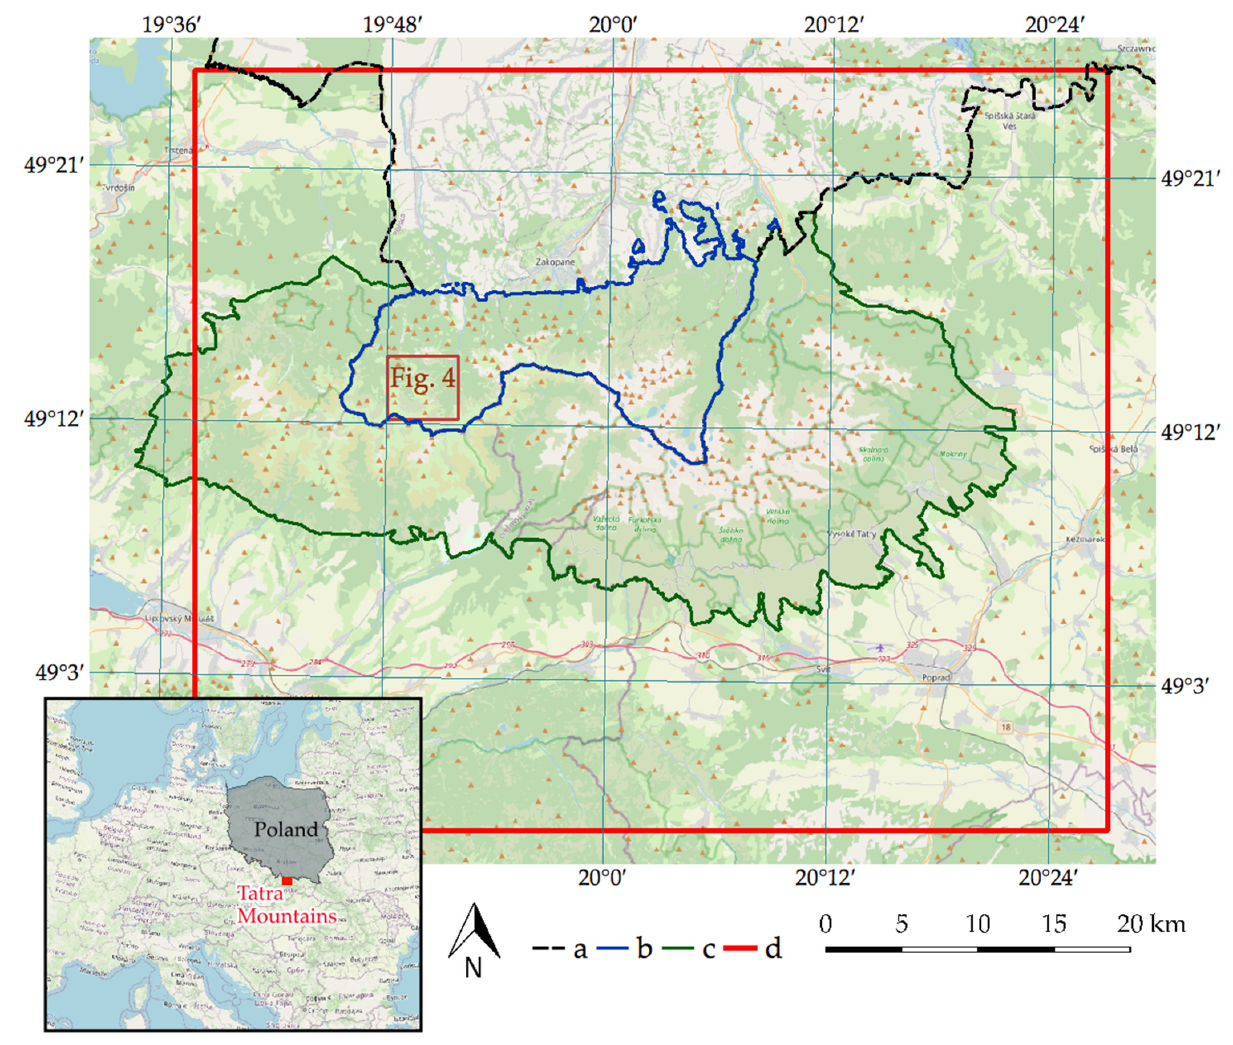
Figure 1. Location of the research area. Explanation: (a) the border between Poland and Slovakia; it also runs along the border between the Polish Tatra National Park and the Slovak TANAP; (b) the border of the Polish Tatra National Park; (c) border of the Slovak TANAP; (d) Sentinel-2 image range; brown polygon range of Figure 4. A map from OpenStreetMap was used in the background.